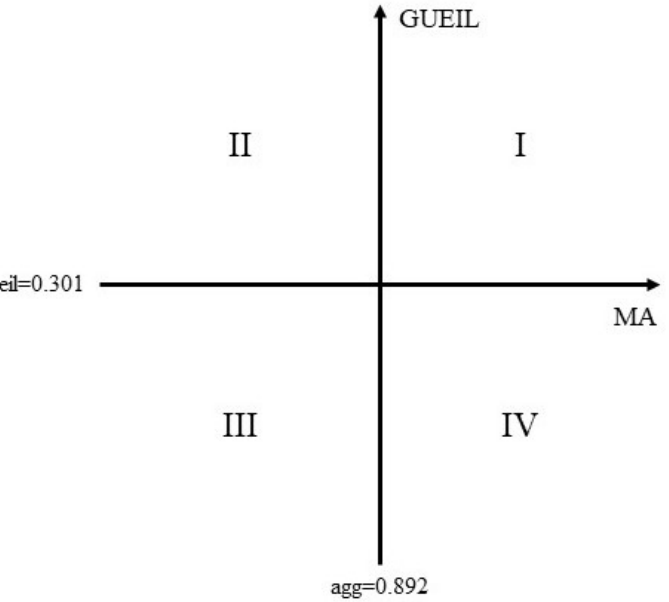
Figure 5. Comprehensive Analysis of MA and GUEIL.